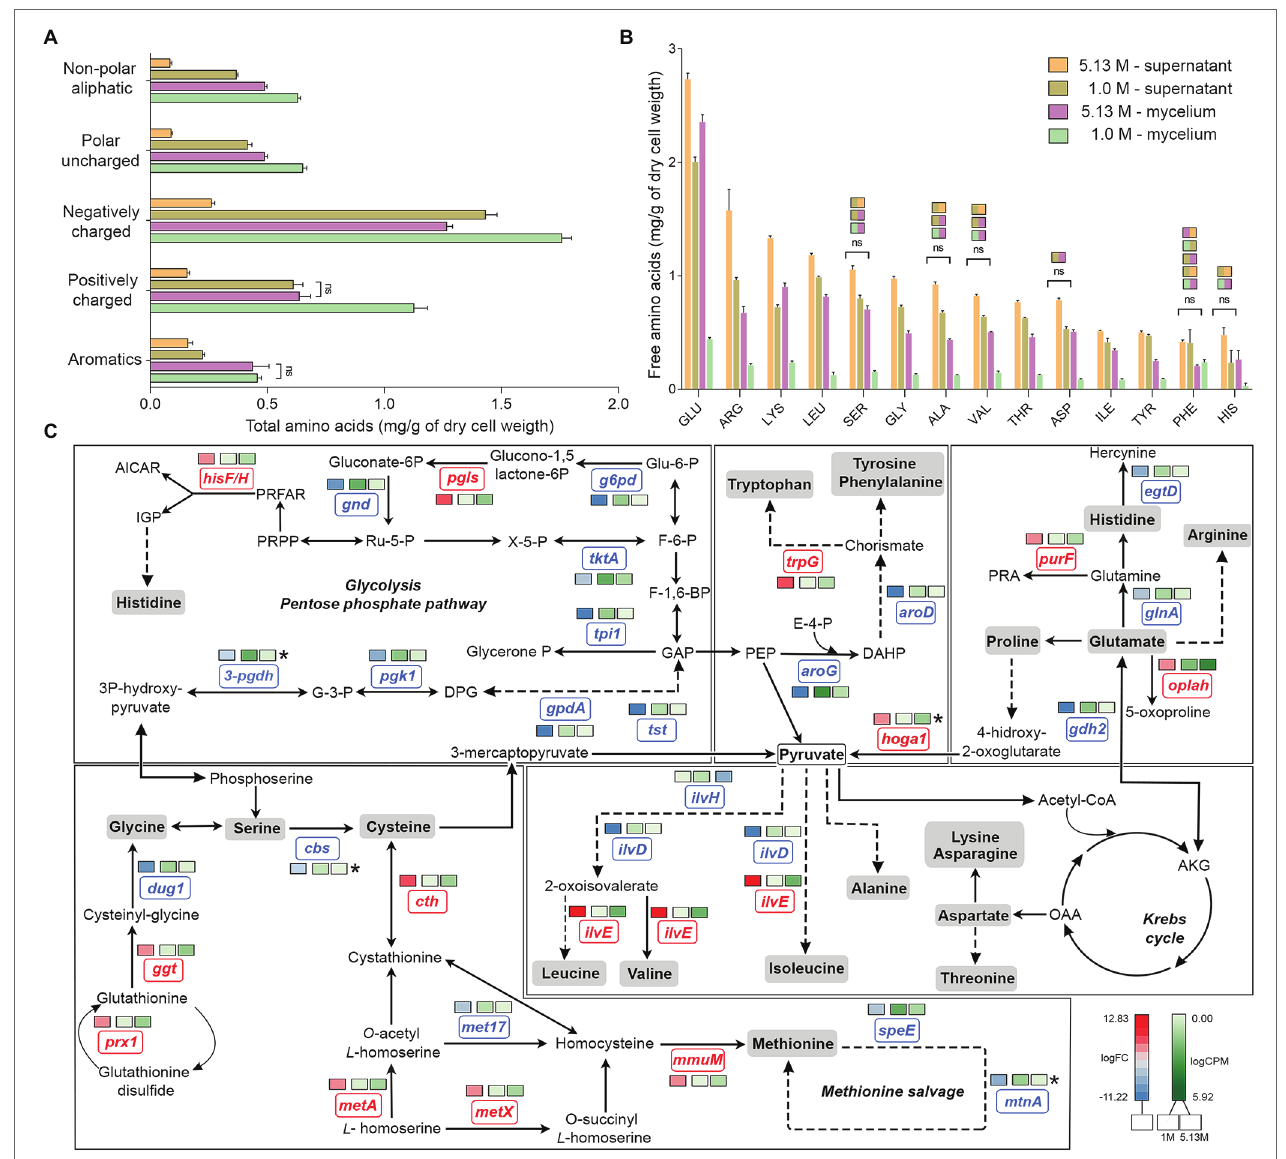
FIGURE 2 | Quantitative profile of amino acids and differential expression of genes related to amino acid metabolism in A. sydowii . (A) Bar chart showing the free amino acids (mg/g of dry cell weight) in both mycelia and supernatants obtained from A. sydowii cultured at 1 M and 5.13 M NaCl. Amino acids are grouped by their side chain characteristics. Except as otherwise noted (ns), all pairwise comparisons are statistically significant by Kruskal–Wallis test—Dunn’s test as post hoc analysis. (B) Bar chart showing the free amino acids (mg/g of dry cell weight) in both mycelia and supernatants obtained from 1 M and 5.13 M NaCl. All pairwise comparisons are statistically significant by Kruskal–Wallis test—Dunn’s test as post hoc analysis—except those marked in the upper color boxes. (C) Metabolic map showing differentially expressed genes (condition of 5.13 M NaCl compared to 1 M NaCl) involved in amino acid biosynthesis pathways. Red and blue boxes/letters indicate genes upregulated (logFC > 1.5) and downregulated (logFC < − 1.5), respectively. Asterisks indicate that two or more transcript isoforms were identified for that gene. The three squares above each gene box illustrate the logFC values and counts per million (CPM) of transcripts in each salt concentration. Dashed and continuous lines refer to intermediate and direct reactions, respectively. AICAR, 5’-phospho-ribosyl-5-amino-4-imidazole carboxamide; IGP, imidazole glycerol-3P; PRFAR, phosphoribulosyl-formiminio-AICAR-P; PRPP, 5-phosphoribosyl diphosphate; Ru-5-P, ribose-5-phosphate; X-5-P, xilulose-5-phosphate; Glu-6-P, glucose- 6-phosphate; F-6-P, fructose-6-phosphate; F-1,6-BP, fructose-1,6-biphosphate; GAP, glyceraldehyde-3-phosphate; PEP, phosphoenolpyruvate; E-4-P, erythrose-4- phosphate; DAHP, 2-dehydro-3-deoxy-arabino-heptonate-7-phosphate; PRA, 5-phosphoribosylamine; OAA, oxaloacetate; and AKG, α